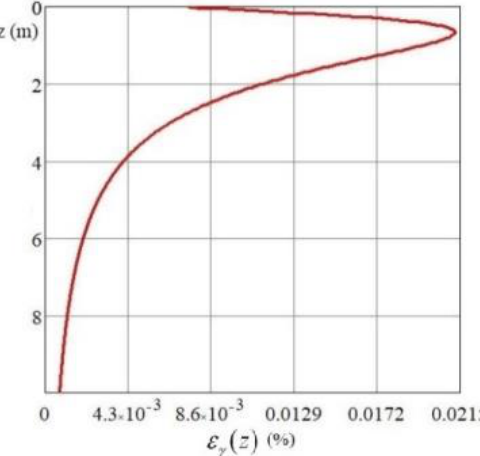
( ) z with depth z . γ